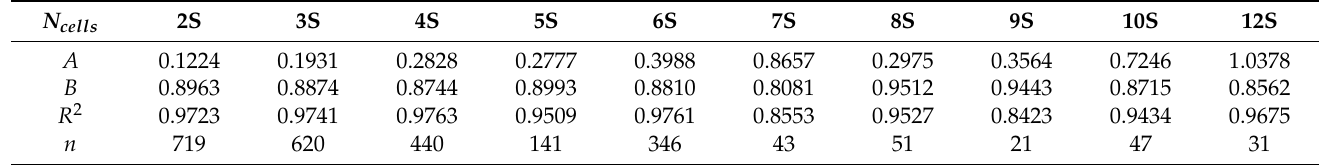
= A · C B Li − Po battery